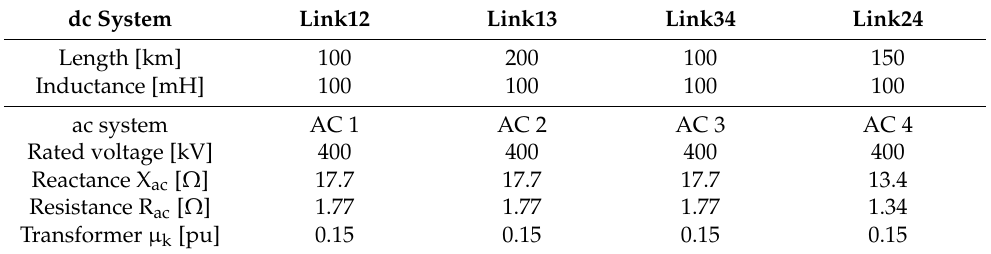
Table 3. AC/dc System parameters.